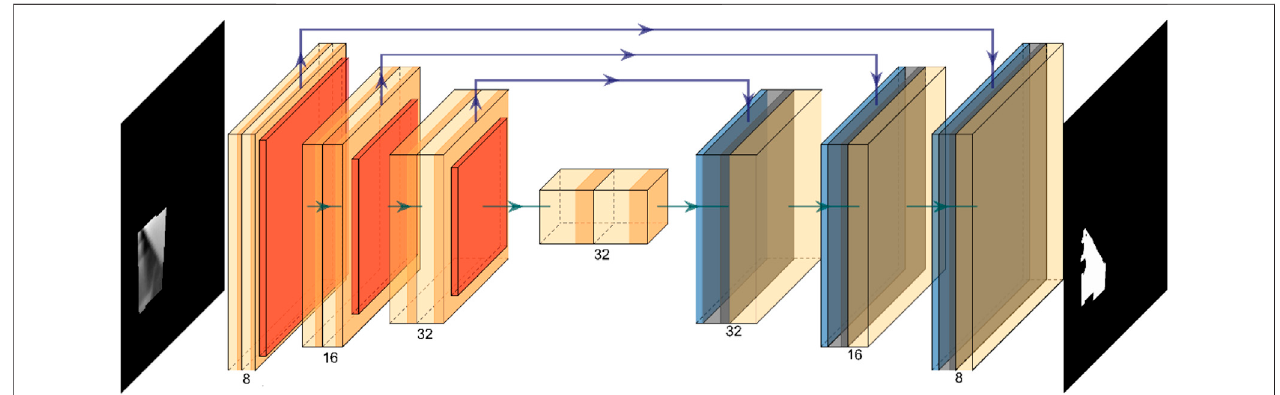
FIGURE 8 | Constructed UNet network with 3 downsampling